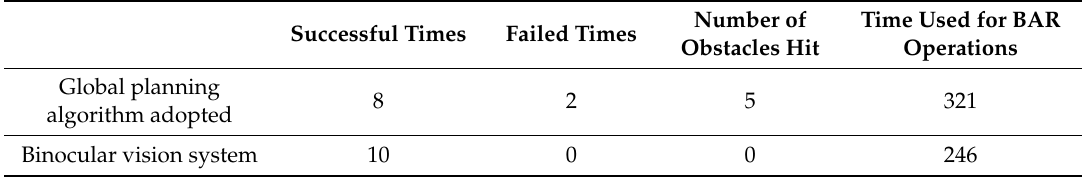
Table 5. Binocular vision system versus conventional method.